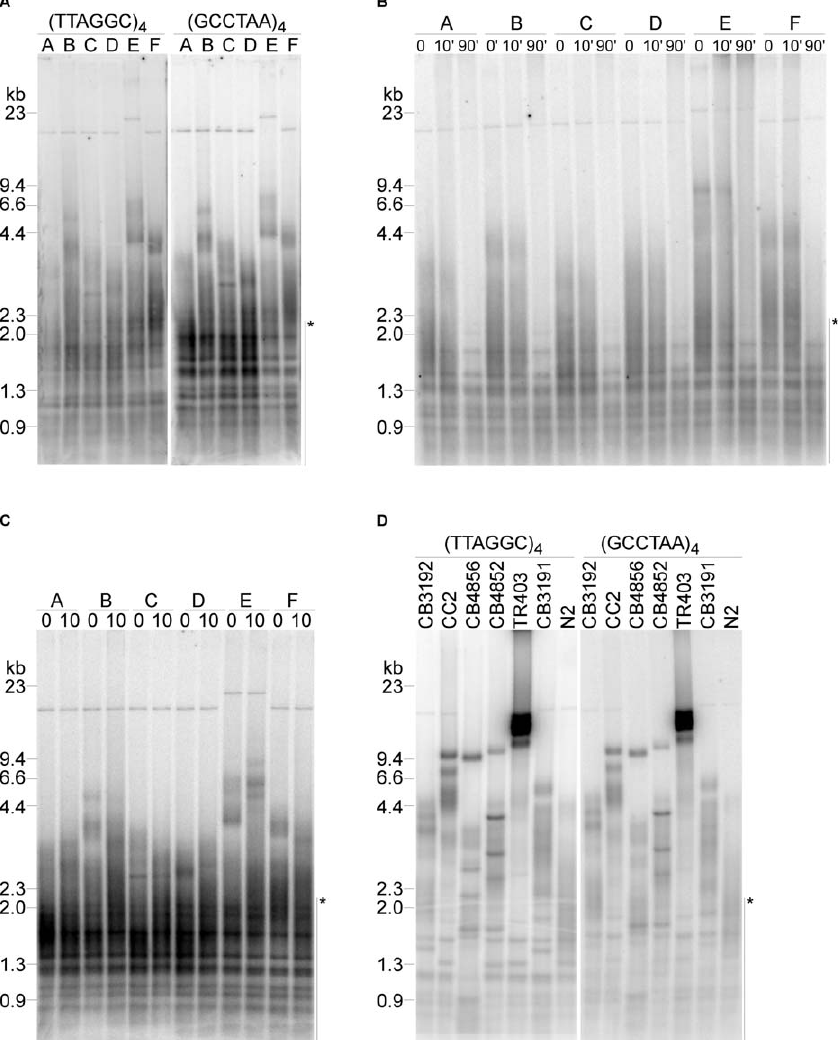
Figure 1. Clonal Variation and Conservation of Telomere Length in C. elegans (A) AluI/MboI digests of genomic DNA from six Bristol N2 clones was separated by gel electrophoresis and hybridized with (TTAGGC) 4 or (GCCTAA) 4 probes as described [28]. Fragment size is indicated in kb, and internal repeats are indicated by an asterisk. (B) DNA from six individual N2 clones was incubated with Bal31 for the indicated time, and then processed as in (A). (C) Six individual N2 clones were propagated for ten generations, and telomere length was determined as described. (D) Seven different C. elegans strains were examined for their telomere length as described in (A). DOI: 10.1371/journal.pgen.0010030.g001